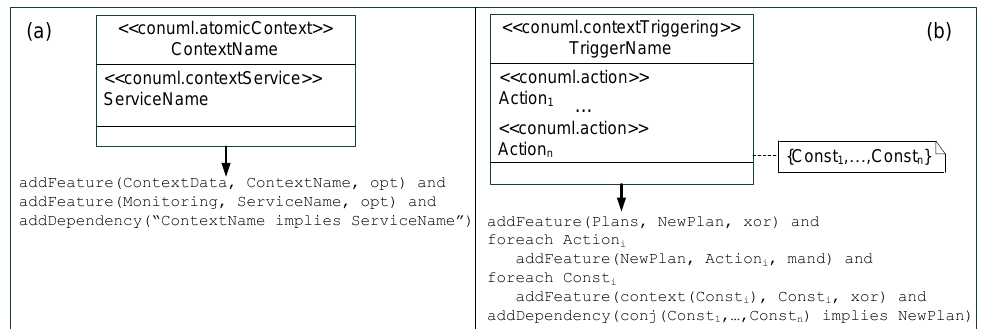
Figure 5. ContextUML to FamiWare